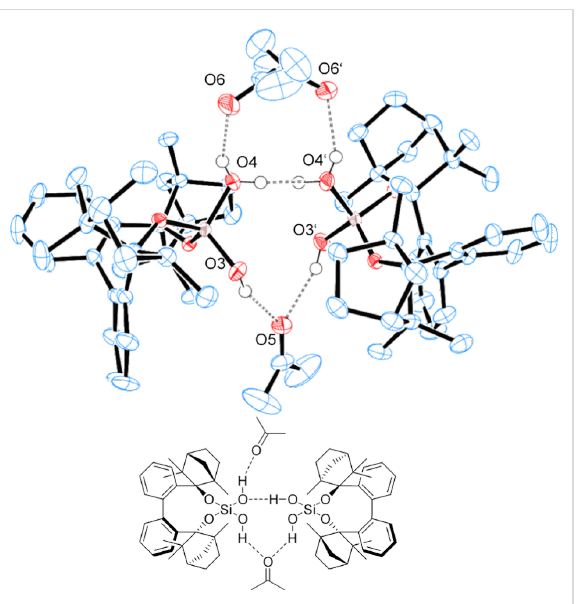
Figure 16: X-ray crystal structure of BIFOXSi(OH) 2 ( 9 ) forming a dimeric structure with two bridged acetone molecules. H atoms on the chiral backbone are omitted for clarity issues. The acetone on the upper side is disordered by 50%. Ellipsoids are shown with 65% prob- ability. For bond lengths and angles see Table 5.